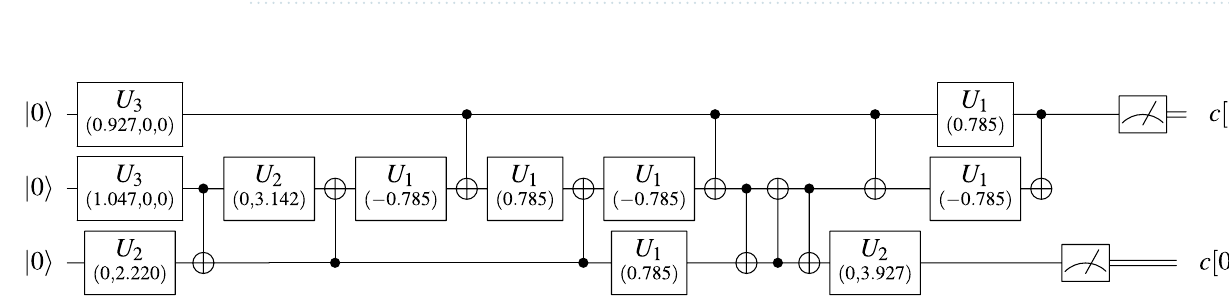
Table 2. Mean test accuracy and one standard deviation for TTN classifiers with ten different random parameter initializations. Three binary datasets were extracted from the original Iris dataset.